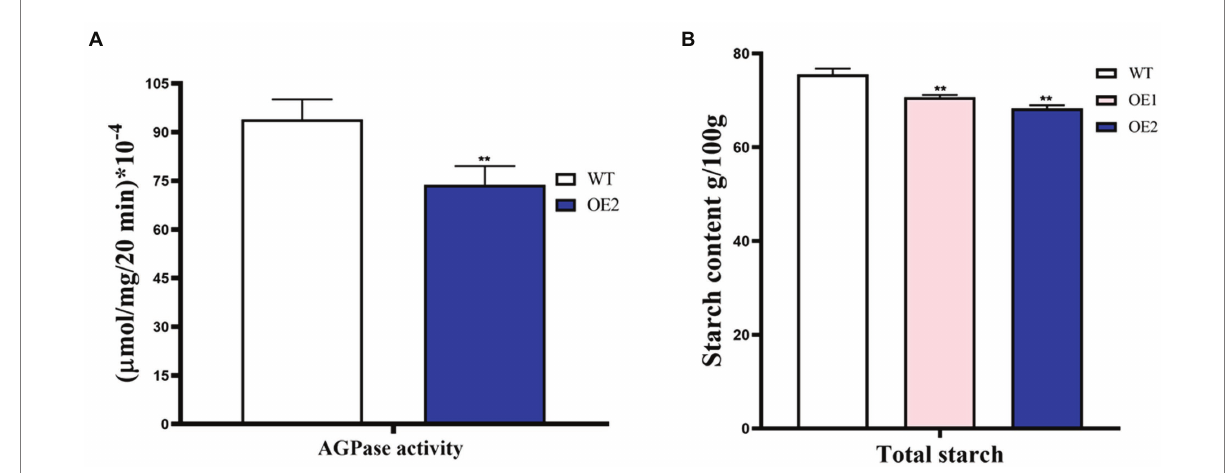
FIGURE 6 AGPase enzyme activity and starch content analyses of T 2 transgenic maize overexpressing ZmTCP7 . (A) In vitro analysis of the AGPase activity of endosperms of transgenic overexpression (OE) line and WT. Developing endosperms at 20 DAP from ears of at least 10 plants were used for AGPase activity; (B) Analysis of starch content in endosperms from mature kernels from OE lines and WT. Kernels from at least 10 ears were used for starch content analysis. At least three independent experiments were performed and results were found to be consistent in all cases. The significance of the difference between OE and the WT was analyzed by a two-sided t -test (** p <